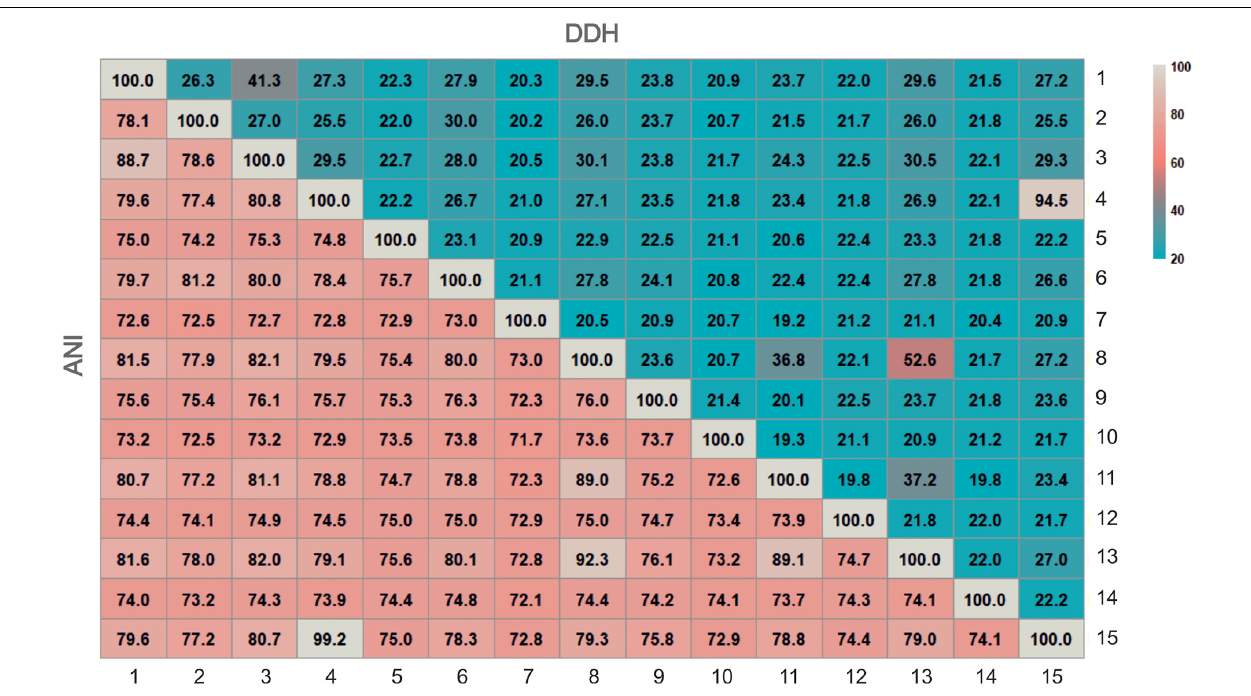
FIGURE 2 | Heatmap of genome relatness among strains F13 T , F24A T , F27 T , F28, members of the genus Halomicroarcula and other related genera by means of OrthoANI and digital DDH. Strains: 1. Halomicroarcula pellucida CECT 7537 T , 2. Haloarcula vallismortis ATCC 29715 T , 3. Strain F13 T , 4. Strain F24A T , 5. Halosimplex carlsbadense 2-9-1 T , 6. Halomicroarcula salina JCM 18369 T , 7. Natronomonas pharaonis DSM 2160 T , 8. Halomicroarcula limicola JCM 18640 T , 9. Halomicrobium mukohatei DSM 12286 T , 10. Halorhabdus utahensis DSM 12940 T , 11. Halomicroarcula amylolytica LR21 T , 12. Halorientalis regularis IBRC-M 10760 T , 13.Strain F27 T , 14. Halapricum salinum CBA1105 T , 15. Strain F28 T . Genome accession numbers are indicated in Figure 1